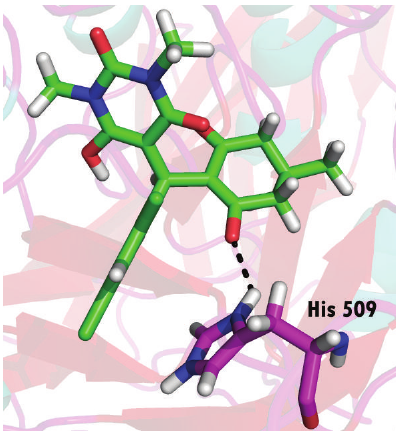
Figure 6: Three-dimensional representation of compound 4w with target enzyme 𝛽